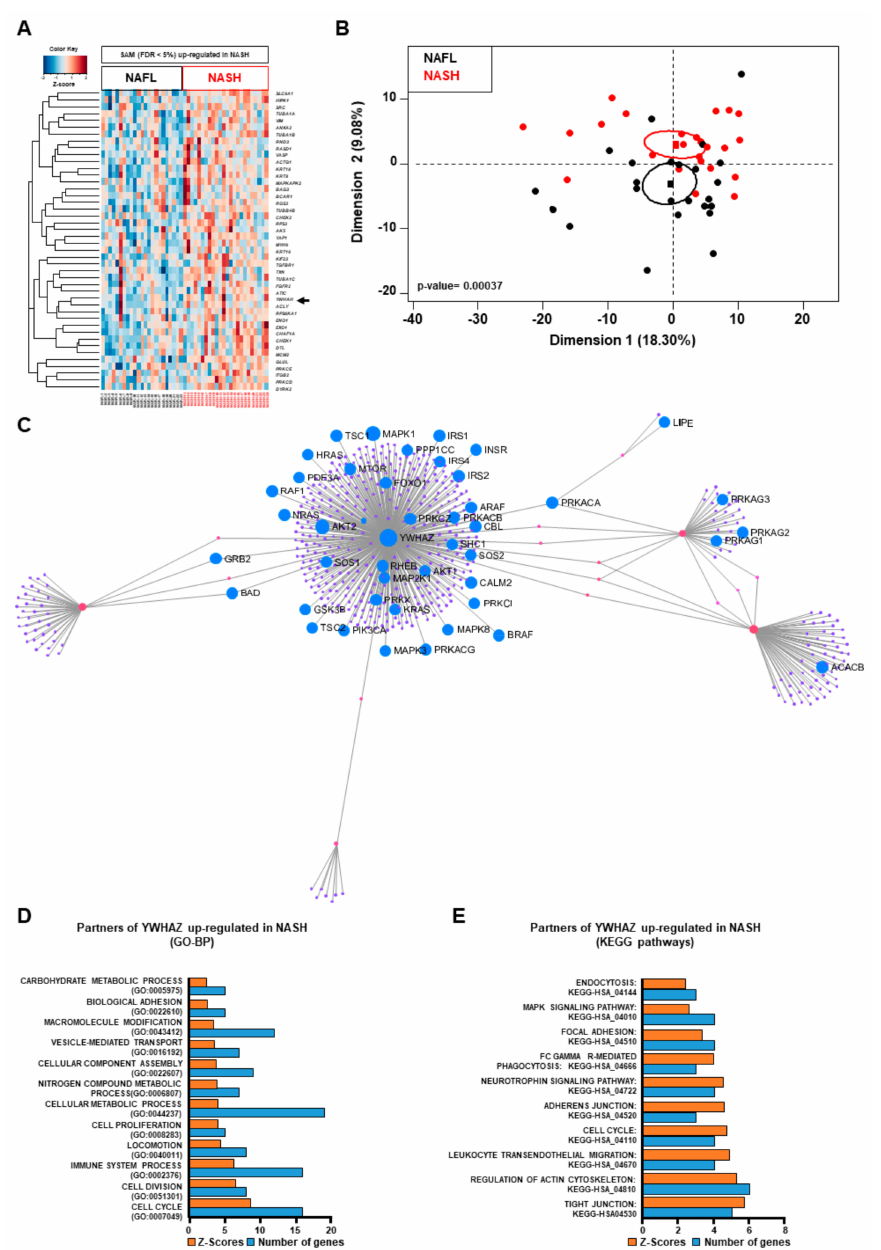
Figure 6. 14-3-3 protein family is at the center of the metabolic, inflammatory and dysregulated insulin pathways. ( A ) Significance Analysis of Microarray identified 44 genes up-regulated linked with YWHAH gene belonging to 14-3-3 protein family and represented by heatmap discriminating NAFL and NASH patients with FDR < 5%. ( B ) Principal component analysis discriminates NAFLD and NASH patients based on 44 genes up-regulated with a global p -value of 0.00037. ( C ) YWHAZ a 14-3-3 protein family and its protein partners ( n = 399) linked to insulin signaling (44 proteins) based on Kyoto Encyclopedia Gene and Genome (KEGG) associated to FDR of q -value = 2 × 10 -19 . Partners of YWHAZ up-regulated in NASH based on ( D ) GO-BP and ( E ) KEGG pathways. FDR: false discovery